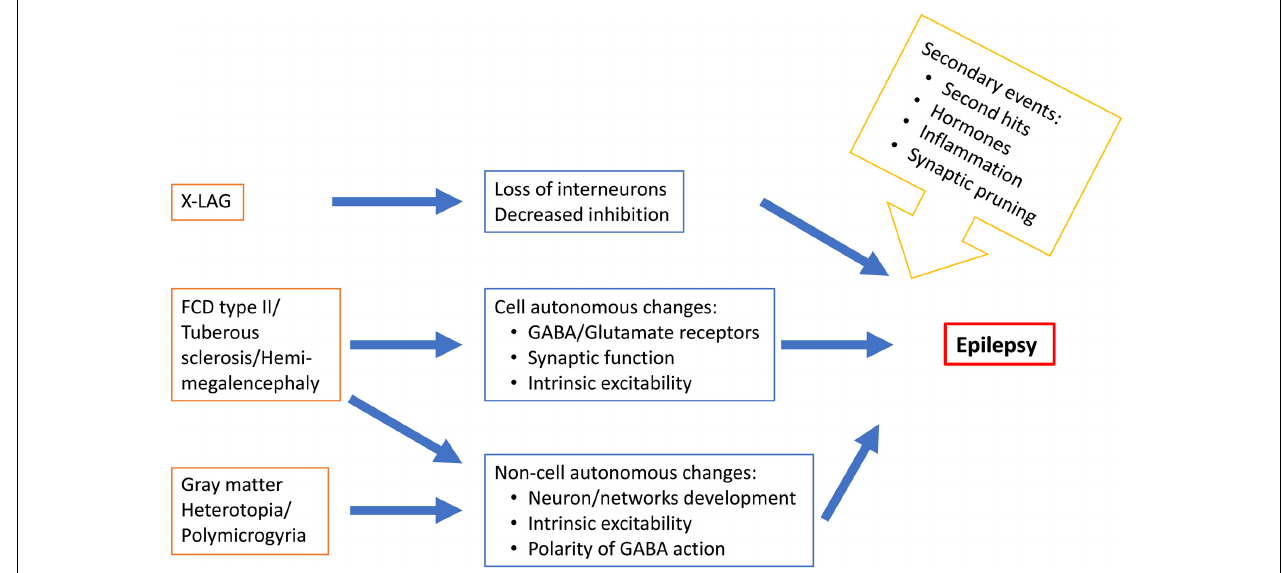
FIGURE 2 | Schematic representation of some MCD-related epileptogenic changes in neurons and neuronal networks.